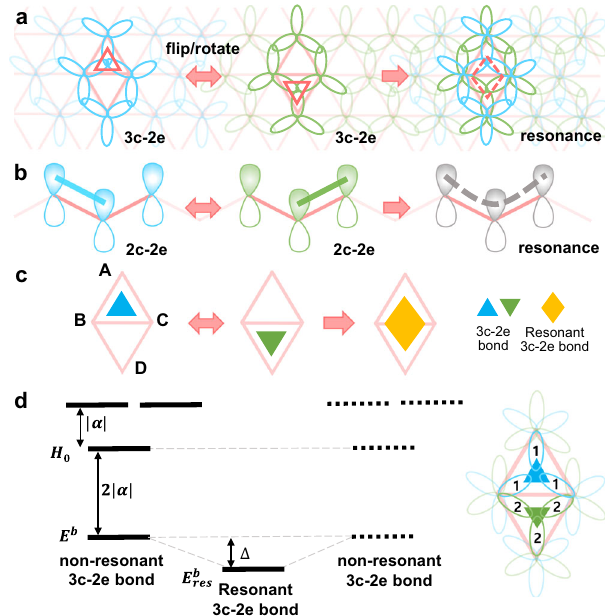
Fig. 1 | A resonance model for alternating 3c-2e bonds in a triangular boron lattice.a Inatriangularboronnetwork(pink),theresonanceofalternating3c-2e σ bondsinneighboringtrianglesleadstoadiamond-shaperesonant3c-2ebond. b In carbon materials, the resonance of alternating 2c-2e π bonds leads to a resonant bond. c A simpli fi ed model of two alternating 3c-2e bonds in a diamond unit con- sisting of four boron atoms denoted as A , B , C , and D . d The energy levels of the linear combination of atomic orbitals (LCAO) of three sp 2 orbitals of a triangular boron unit as that shown in Ref. 19 . The lowest energy state, E b = H 0 (cid:1) 2 ∣ α ∣ , corre- sponds a 3c-2e bond, where H 0 is the Coulomb integral and α is the exchange integral of two neighboring B atoms with the same sp 2 σ orbital alignment. The resonanceofthetwoalternating3c-2ebondsfurtherreducestheenergyfrom E b to 4 = 4 ∣ β ∣ , where β is the exchange integral of two neighboring B atoms with E b res by 3 opposite sp 2 σ orbital